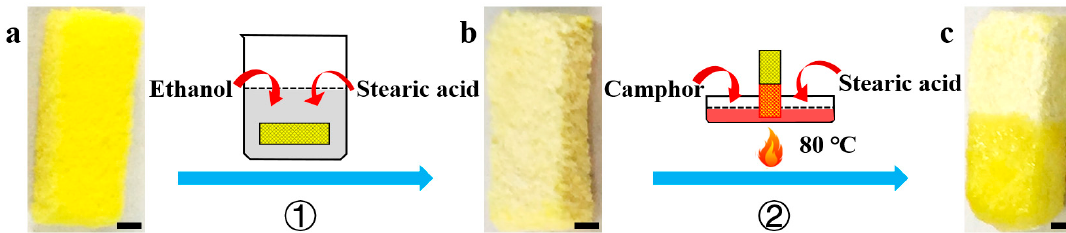
Figure 1. Schematic illustration of the fabrication of the Janus foam motor. At first, the pristine polyvinyl alcohol (PVA) foam ( a ) was modified with stearic acid (SA) by soaking it in SA ethanol solution (step 1) and drying in air to prepare SA-PVA foam ( b ). Then, the Janus foam motor ( c ) was prepared by loading camphor/SA mixture into one end of the SA-PVA foam at 80 °C (step 2). Scale bars: 1 mm.